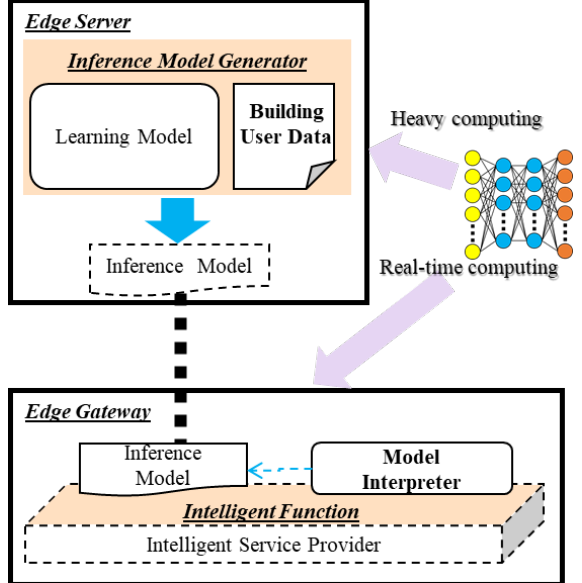
Figure 5. Scenario of the offloading learning and inference model for intelligent edge computing.